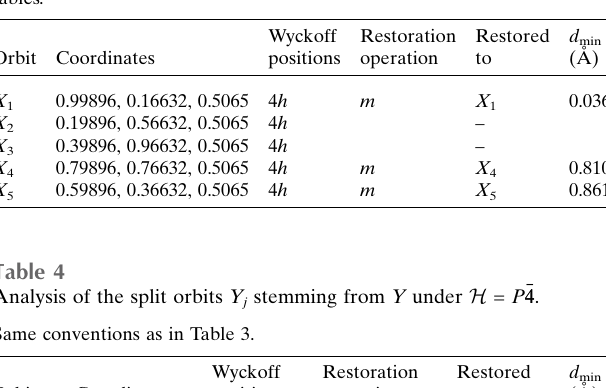
Table 3 Analysis of the split orbits X j stemming from X under H = P (cid:2) 44.